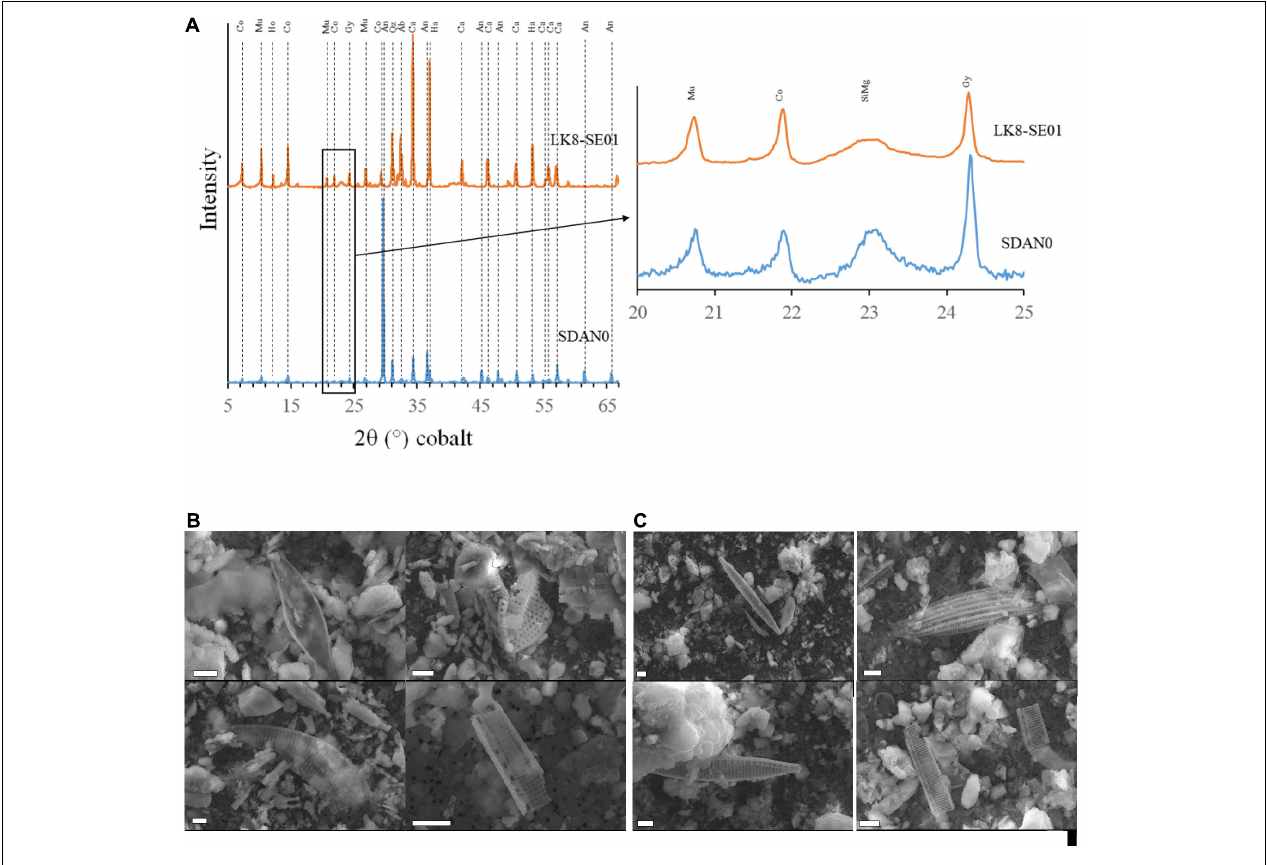
FIGURE 6 | Common sedimentary signatures in Dallol and the Afrera Formation. (A) X-ray diffractograms of sediments collected from the Afrera Formation (LK8-SE01) and Dallol (SDAN0). Major peaks were assigned to calcite (Ca), gypsum (Gy), anhydrite (An), muscovite (Mu), corrensite/chlorite (Co), halite